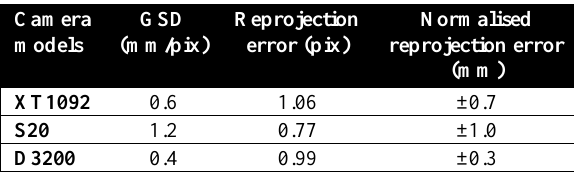
Table 1 . Photogrammetric parameters of SfM